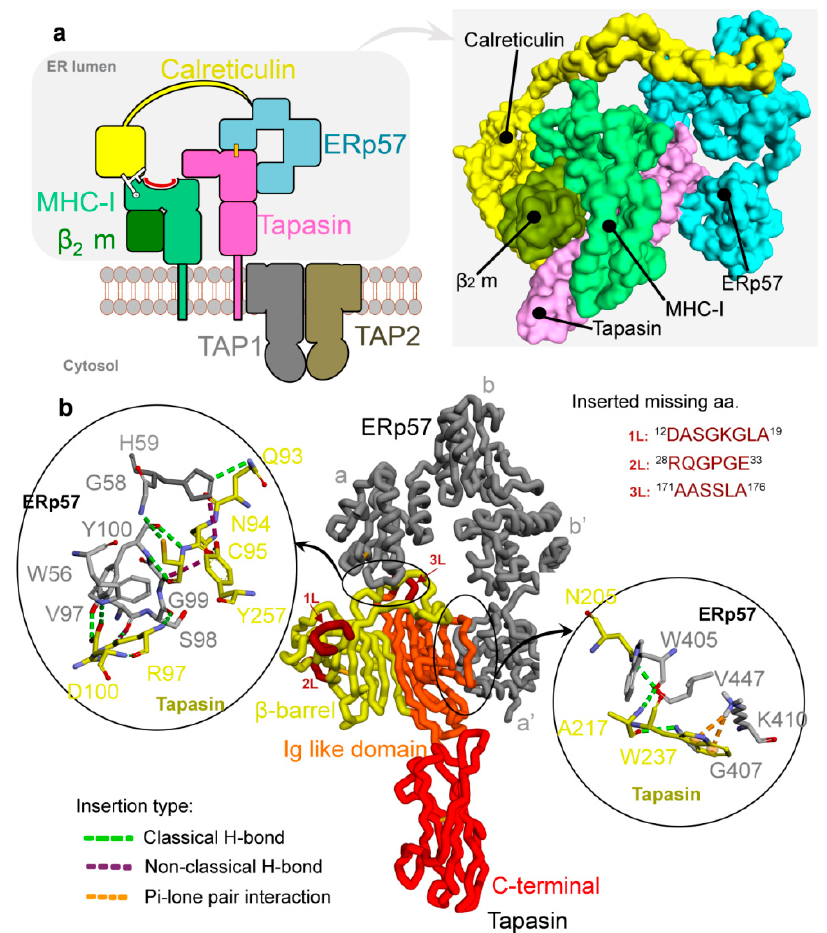
Figure 1. Structures of the peptide-loading complex(PLC) components and ERp57-tapasin complex. ( a ) Schematic representation of individual assembly factors of the PLC showing TAP1, TAP2, tapasin, MHC-I heavy chain (hc), β 2 m, calreticulin, and ERp57 (disulphide bridge is shown as orange line and monoglucosylated (G) N-glycan as white lines) [4], and the structural architecture of fully assembled PLC (PDB ID: 6ENY) [4]. ( b ) The structure and interactions (H-bonds) of the ERp57-tapasin wild-type heterodimer (PDB ID: 3F8U) [22]. N-terminal domain of tapasin is a fusion of β -barrel (residues 1–147) and an Ig-like domain (residues 150-269), and the C-terminus domain (residues range 270–381) of tapasin is similar to the Ig-like domain [22]. Interaction types include classical hydrogen (conventional H-bonds; coloured in green), non-classical hydrogen (carbon hydrogen bond; in purple), and Pi-lone pair interactions (Pi-donor; in orange colour). Missing residues (range: 12–19, 28–33, and 171–176) in the tapasin structure were inserted and shown as dark red colour regions with labels 1L, 2L, and 3L, respectively. Colour scheme: carbon in grey (ERp55) and yellow (tapasin), oxygen in red, nitrogen in blue, hydrogen in silver, and sulphur in orange.